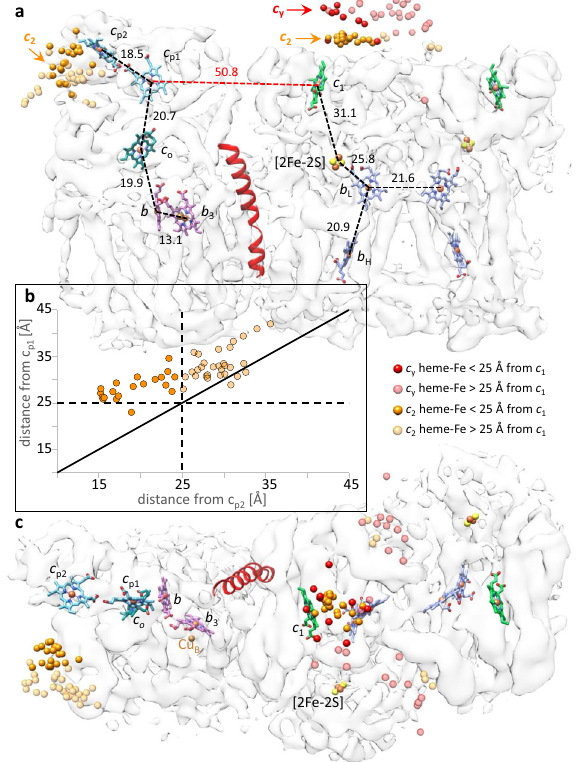
the electron exit site of CIII 2 48,49 , the cluster on cyt c 1 was taken as the productive binding region of cyt domain of c y .